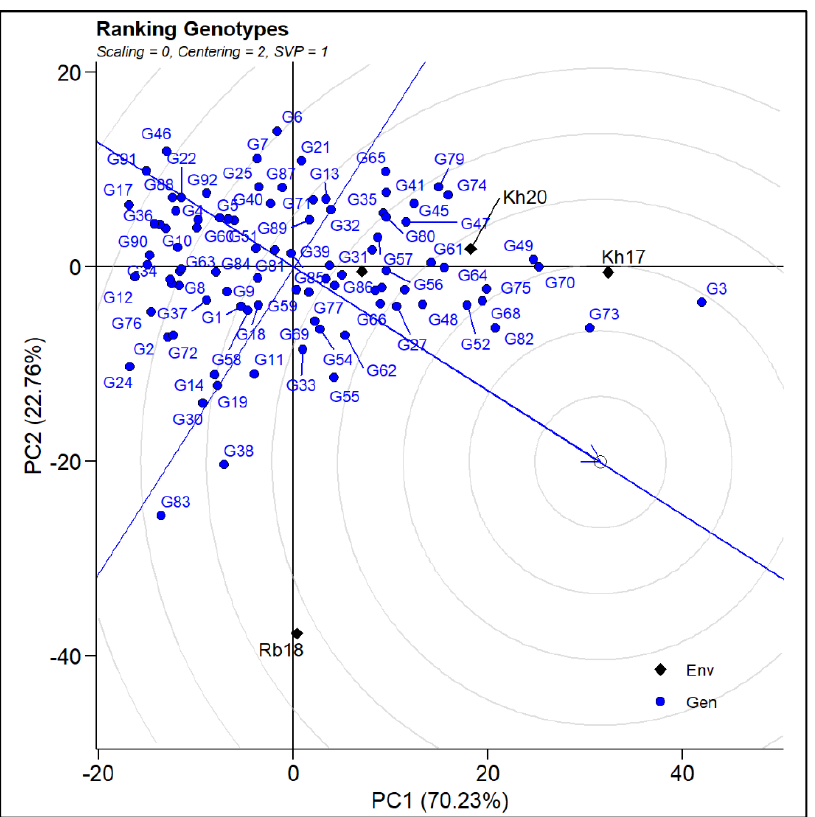
Figure 3. Ranking of genotypes across all seasons.